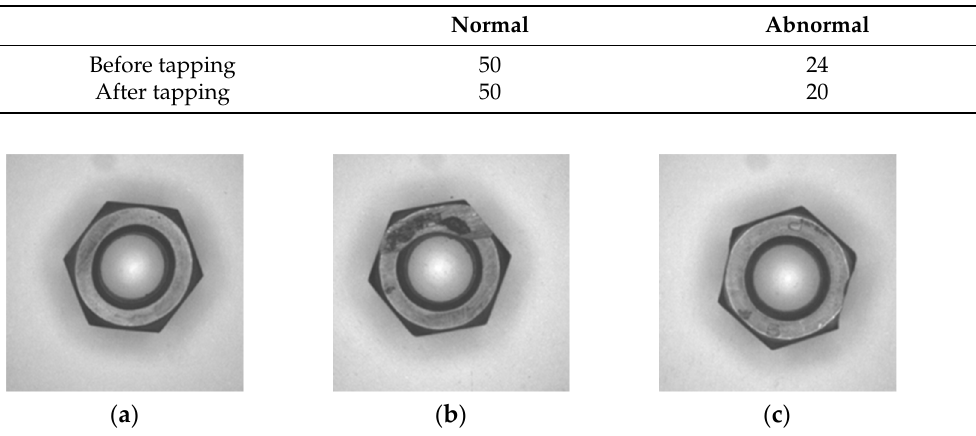
Figure 13. Abnormal nut before tapping: ( a ) circle anomaly; ( b ) plane anomaly; ( c ). line anomaly.